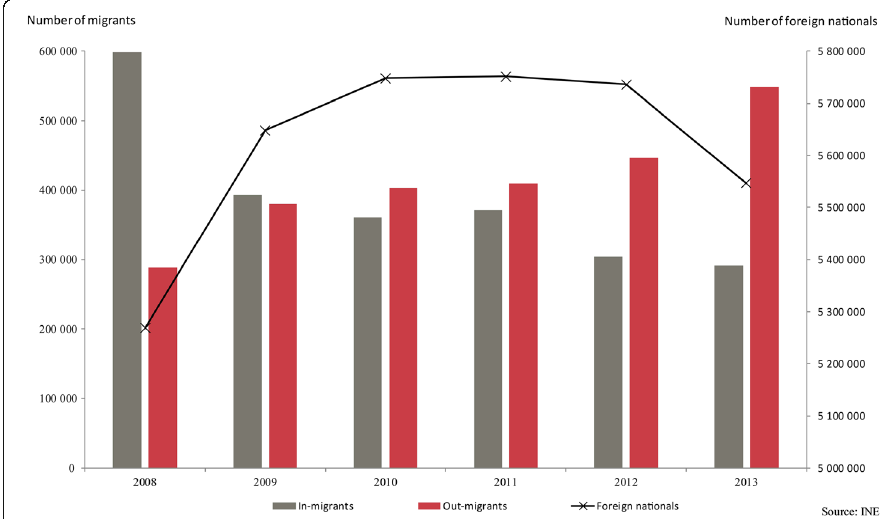
Fig. 2 Net migration component and foreign nationals in Spain from 2008 to